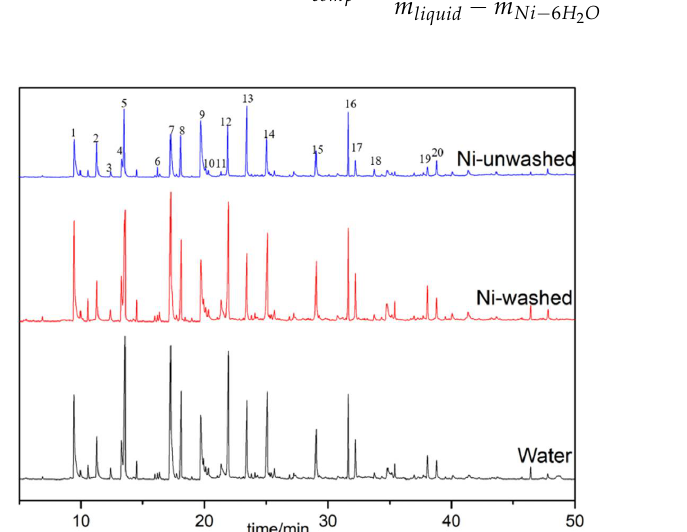
Figure 3. The GC-MS spectra of bio-oil derived from pyrolysis (1: phenol; 2: Benzyl alcohol; 3: o-